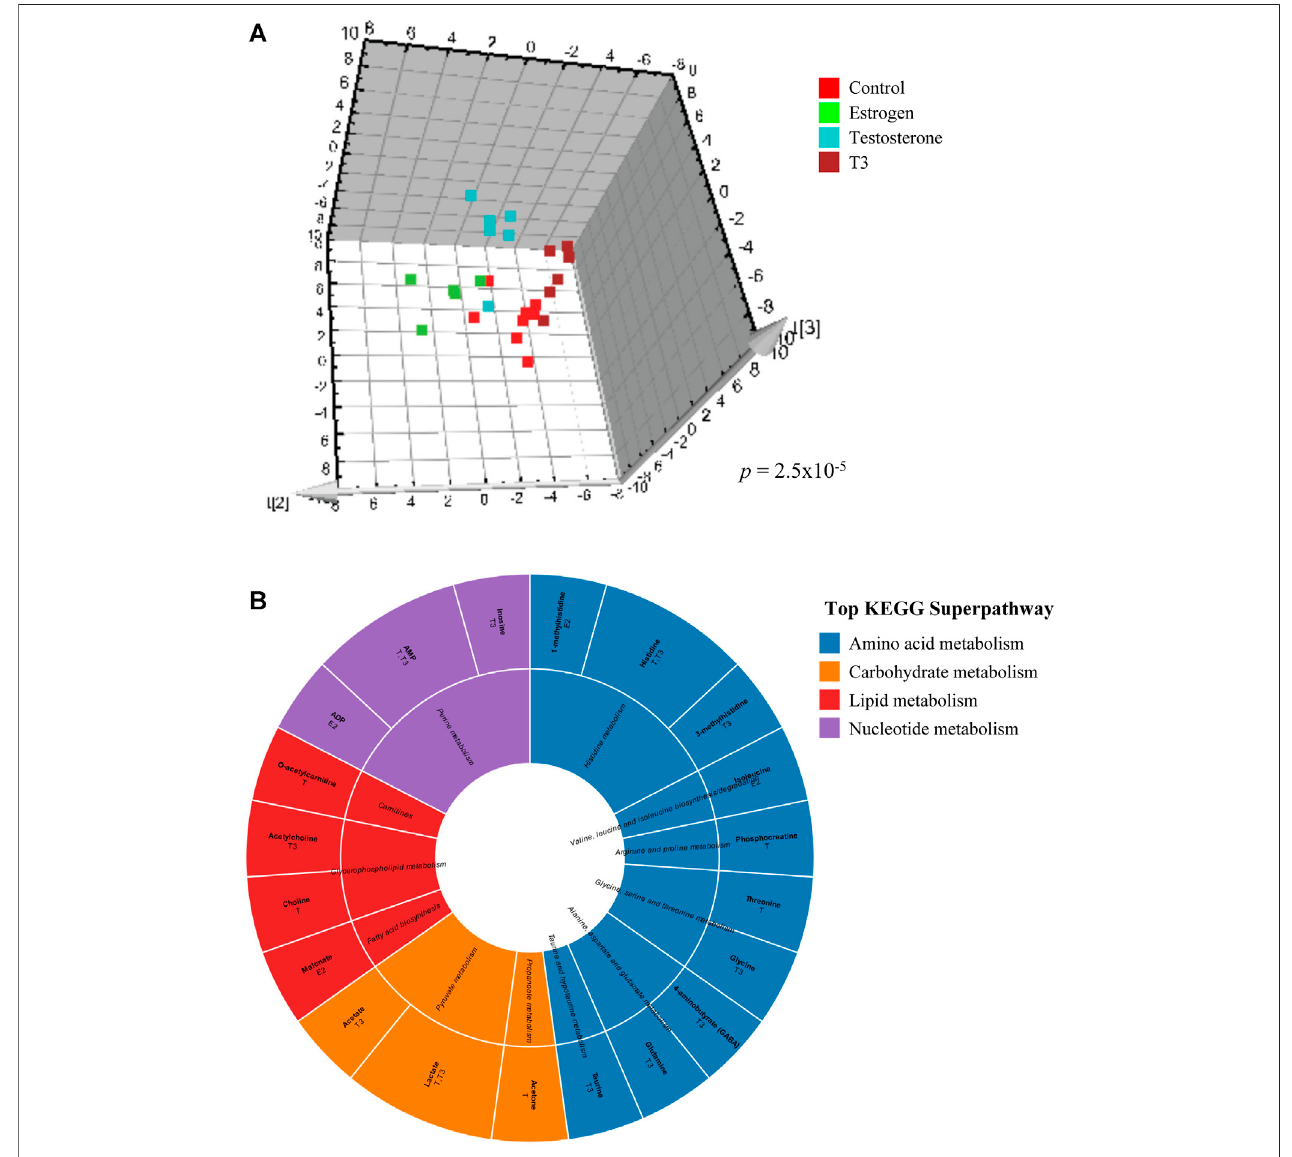
FIGURE 2 | Effects of hormone treatments on midbrain metabolome of male gold fi sh in October. (A) Supervised O2PLS-DA analysis score plot illustrating the effectsofcontrol,estradiol,testosteroneandT3onmidbrainmetabolicpro fi leinmalegold fi shtreatedinOctober.Eachpointrepresentslogtransformednormalizedand UV scaled metabolite concentrations from 1 H-NMR spectra. Each axis represents an orthogonal component that is a source of variation between the samples. (B) Sunburst diagram depicting metabolites altered by individual hormone exposures in midbrain in October. Metabolites depicted are those with VIP score > 1 in pairwise control vs treatment O2PLS-DA modeling. The diagram includes annotation of speci fi c hormone treatments found to alter each metabolite. Metabolites and associated biochemical pathways are color coded by KEGG superpathways.